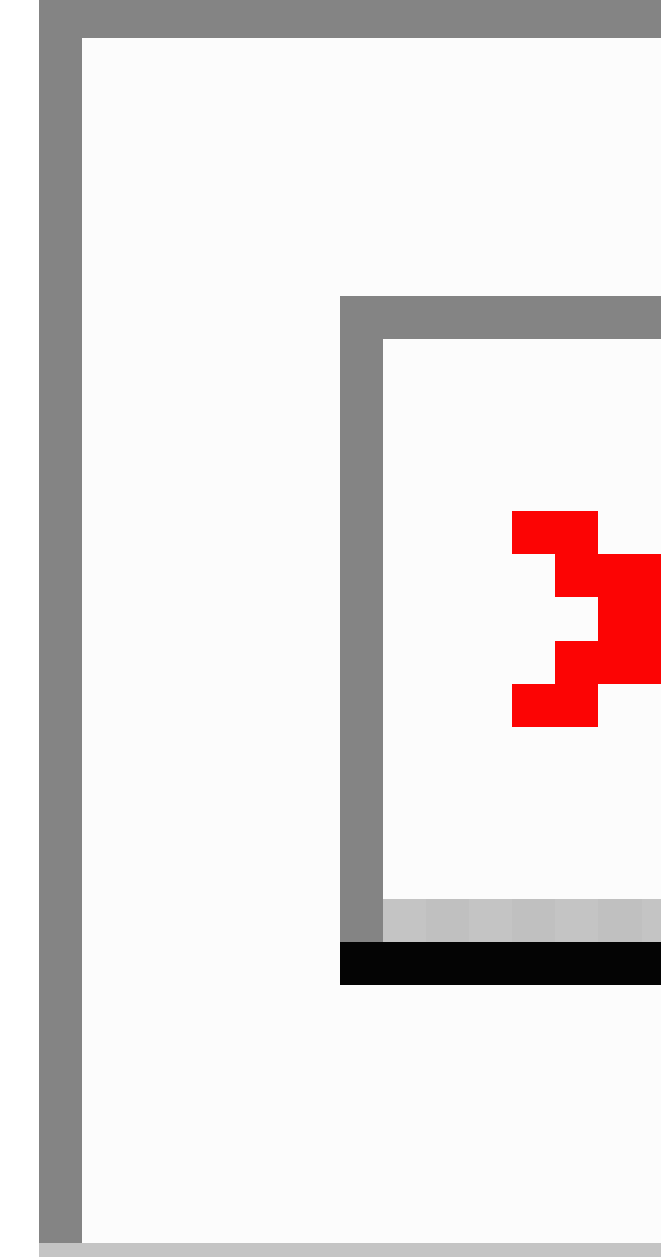
Figure 1. Summary of the systematic literature review process.